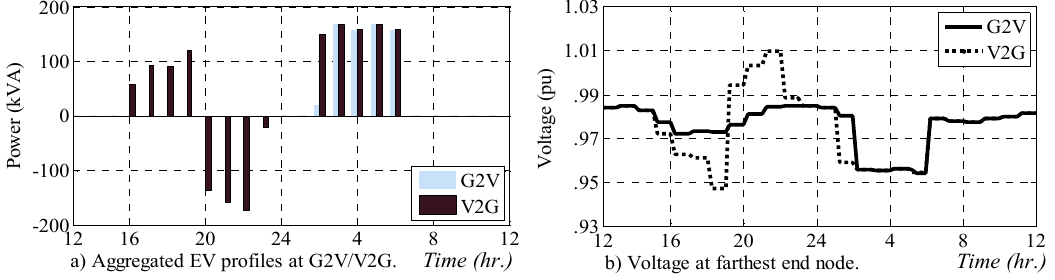
Figure 13. EV charging/discharging from aggregator perspective.